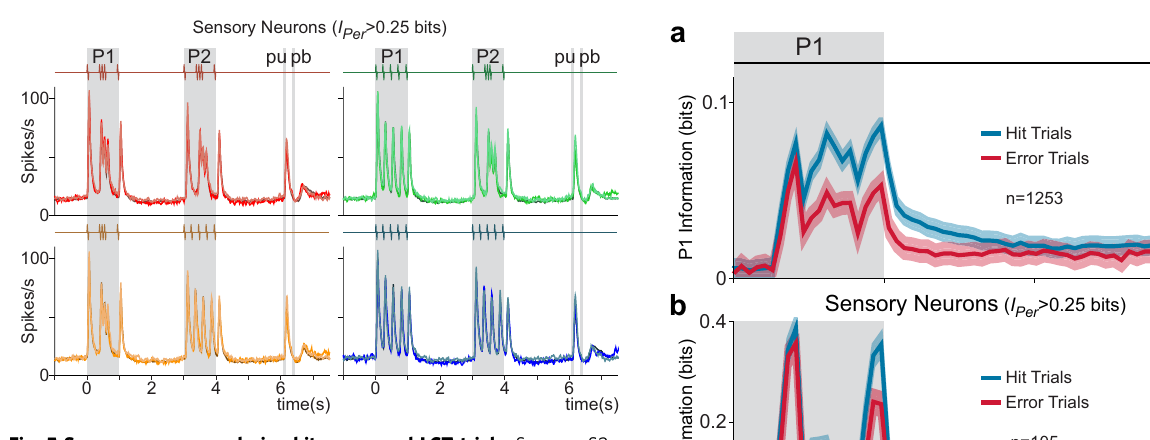
sensory neurons were the fastest, and categorical the slowest, for S2 neurons. Moreover, the population recorded during the LCT ( n = 313, Supplementary Fig. 12d) displayed a trend to be faster than the TPDT population for both latency types (response: 72 ms vs. 97 ms; coding: 363 ms vs. 432 ms).